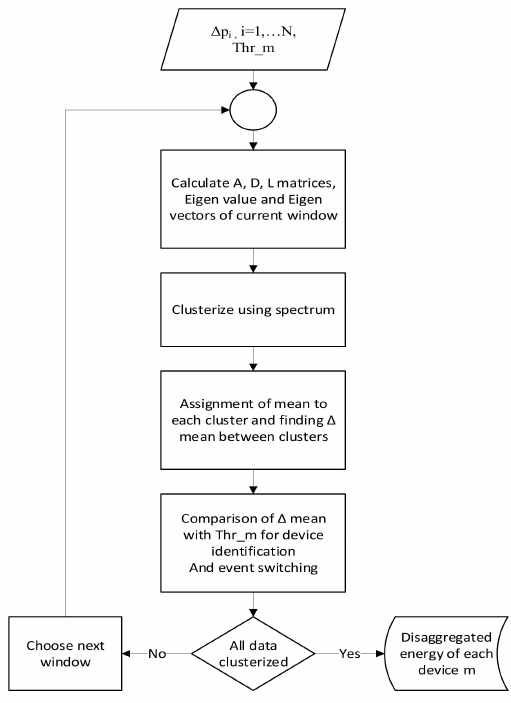
Figure 4. Flow chart of SC-M